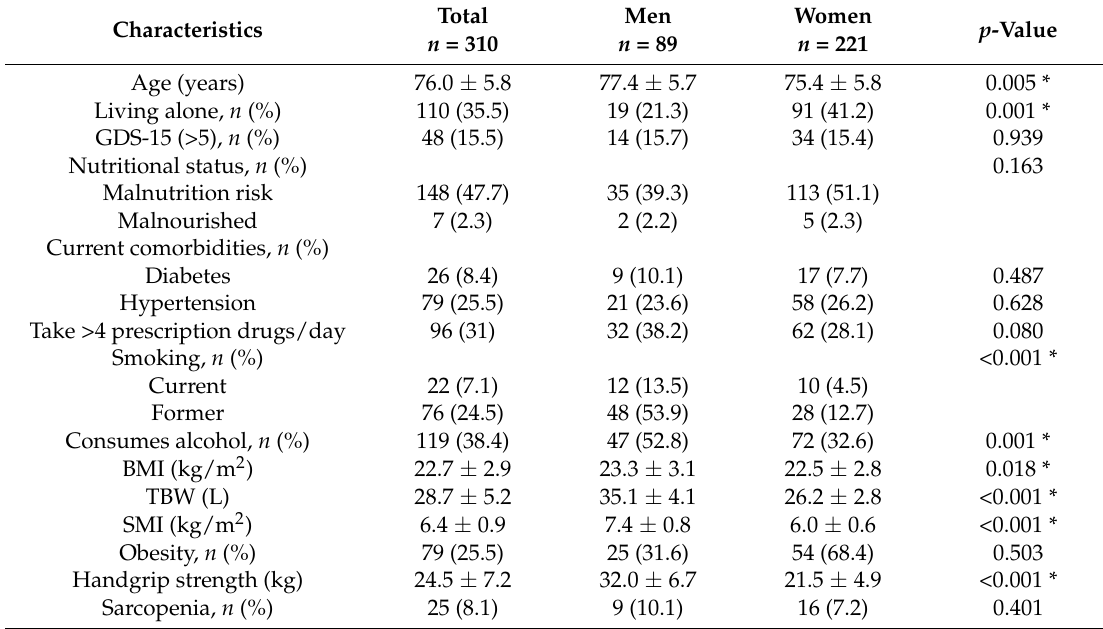
Table 1. Characteristics of the study participants according to sex.